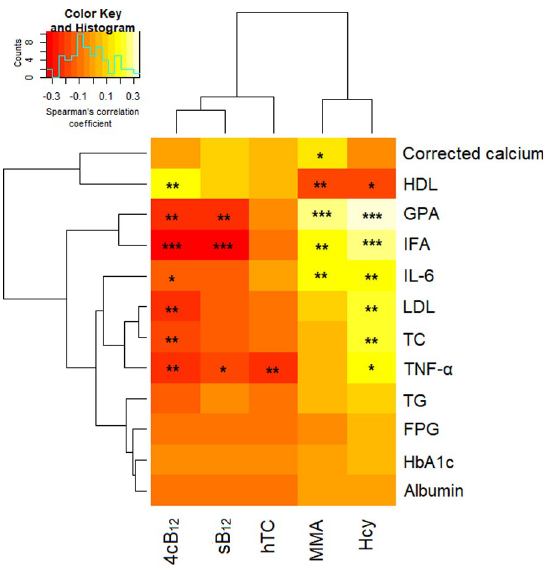
Fig 4. Correlation between indicators of vitamin B 12 and the immunological parameters. Hierarchical clustering by Spearman’s correlation was used to assess relationship between adipokines and their ratios with obesity indices. Red- yellow-white coloration represents negative (-) to positive (+) correlation coefficient. � ; p < 0.05, �� ; p < 0.01, ��� ; p < 0.0001.